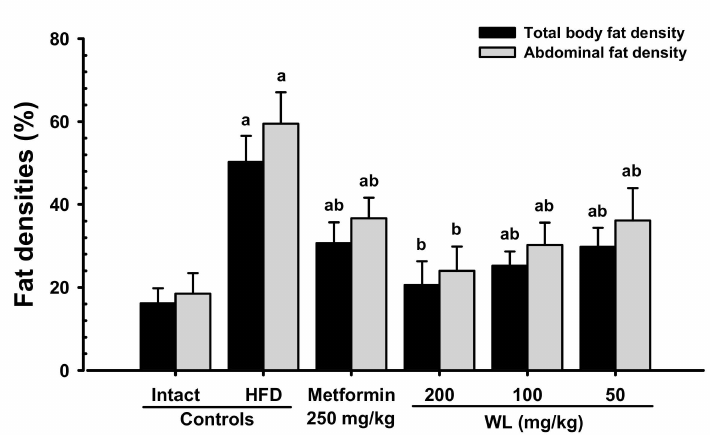
Figure 2. Representative gross body mass and abdominal fat pads with whole body DEXA images taken from NFD or HFD supplied mice. ( a ) Vehicle (distilled water) 10 mL / kg orally administered mice with NFD supply (Intact control); ( b ) Vehicle 10 mL / kg orally administered mice with HFD supply (HFD control); ( c ) 250 mg / kg of metformin oral administered mice with HFD supply (Metformin); ( d ) WL 200 mg / kg orally administered mice with HFD supply (WL200); ( e ) WL 100 mg / kg orally administered mice with HFD supply (WL100); ( f ) WL 50 mg / kg orally administered mice with HFD supply (WL50). Left column = bone; middle column = tissue; right column = composition (red = lipid; blue = protein). NFD = Normal pellet diet; HFD = 45% Kcal high-fat diet; WL = Wasabi Leaf / Folium, Wasabia japonica (Miq.) Matsum extracts; DEXA = Dual-energy X-ray absorptiometry. Scale bar = 12.8 mm.